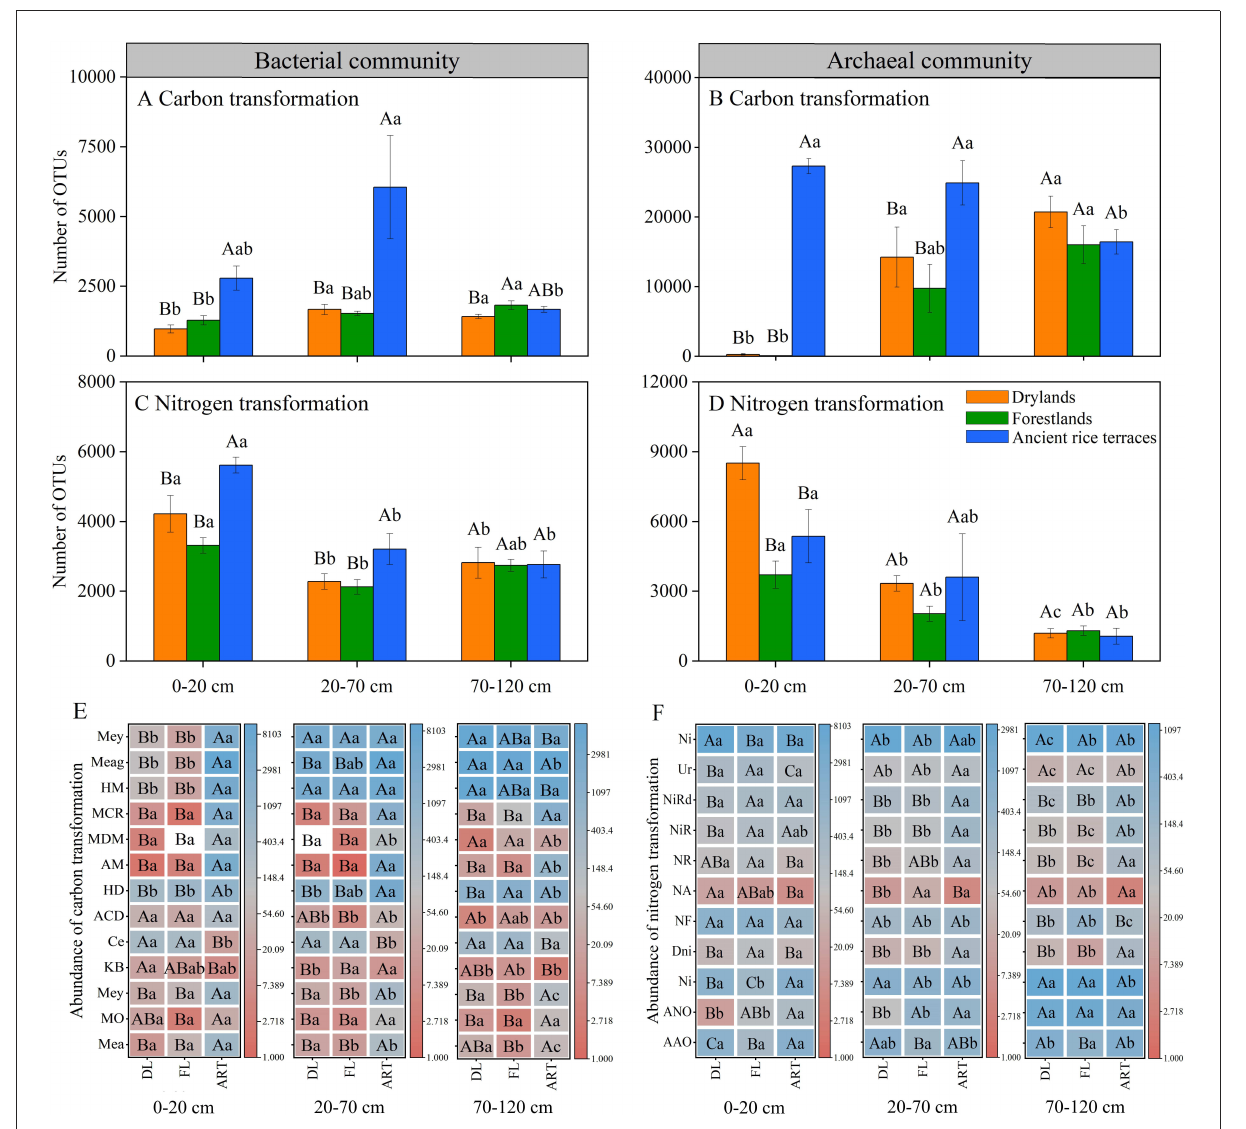
FIGURE5 Prokaryotic functional annotation (FAPROTAX) analysis was used to evaluate the abundance of carbon and nitrogen transformations in soil prokaryotic communities of three land use types in different soil horizons. Various capital letters stand for significant differences among diverse land use types, diverse lower-case letters indicate significant differences among diverse soil horizons. (A–D) Indicate the abundance of total carbon and nitrogen transformations in soil bacterial and archaeal communities, respectively; (E,F) indicate the abundance of